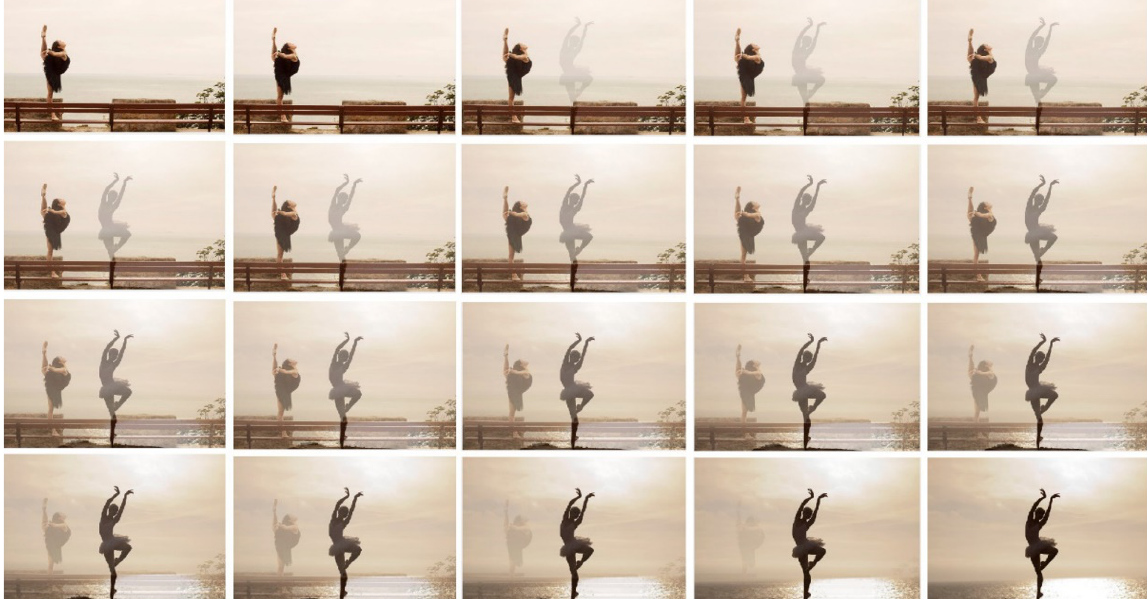
Figure 4. Example of Linear combinatios of two different imagens (Pinterest,